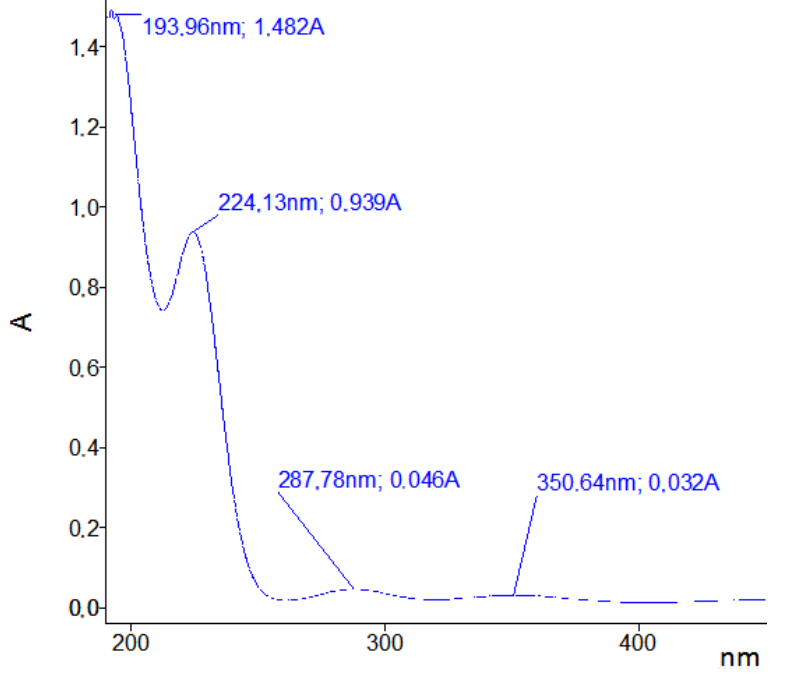
Figure 5. UV spectrum of the FS-1 drug.